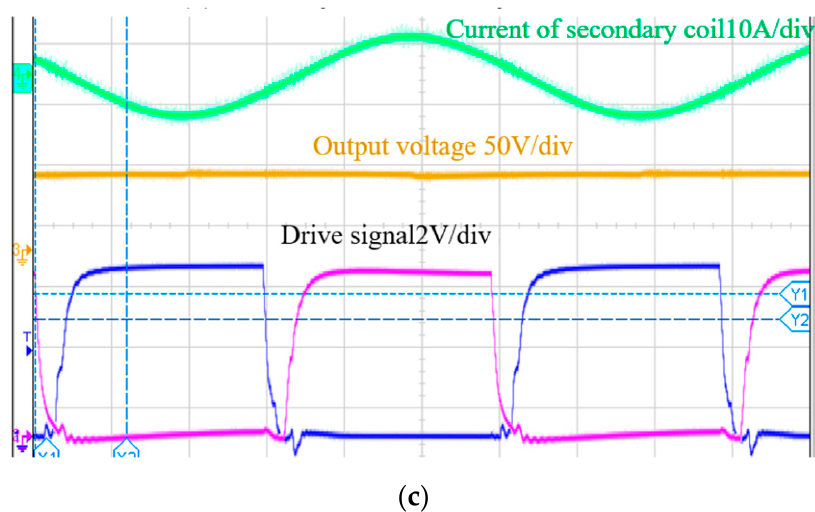
Figure 24. Experimental verification of constant current wireless charging system: ( a ) inverter output voltage and primary coil current, ( b ) primary and secondary coil current, ( c ) drive signal, secondary coil current and load voltage.